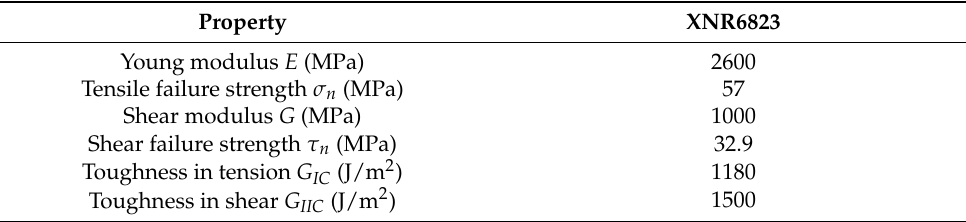
Table 3. Properties of adhesive.